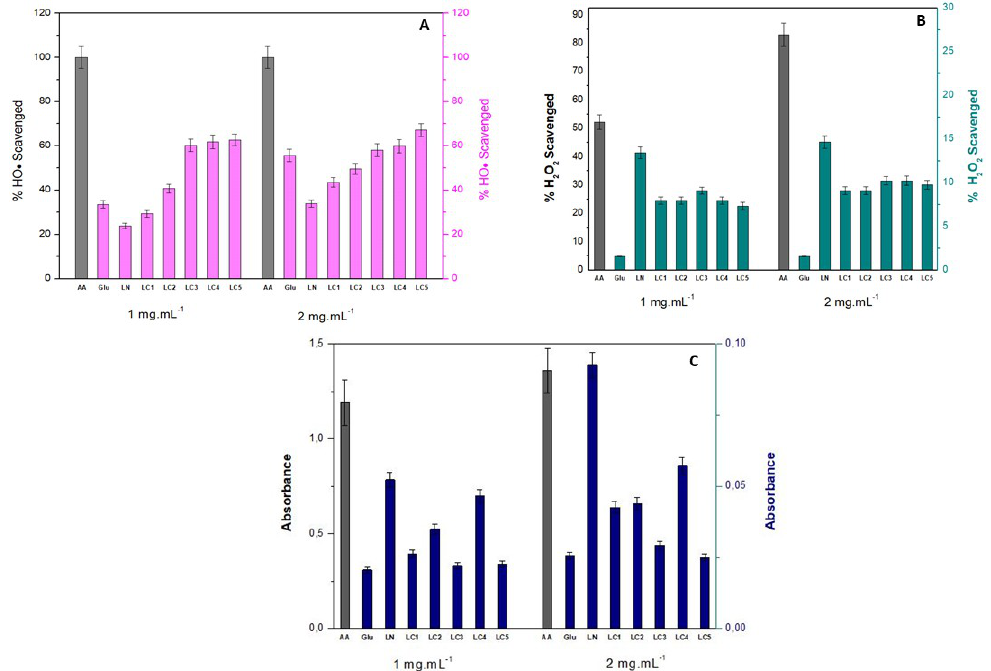
Figure 6. Antioxidant activity of native lasiodiplodan (LN), carboxymethylated lasiodiplodan (LC), glucose (GLU), and ascorbic acid (AA) (antioxidant standard) measured by ( A ) HO • scavenging; ( B ) H 2 O 2 scavenging, and ( C ) reducing